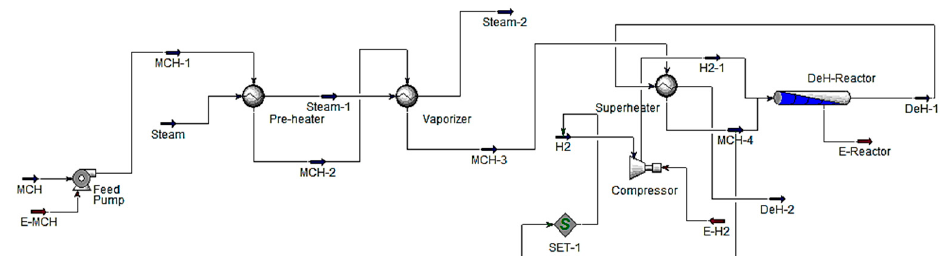
Figure 2. Process flow diagram of the methylcyclohexane dehydrogenation.